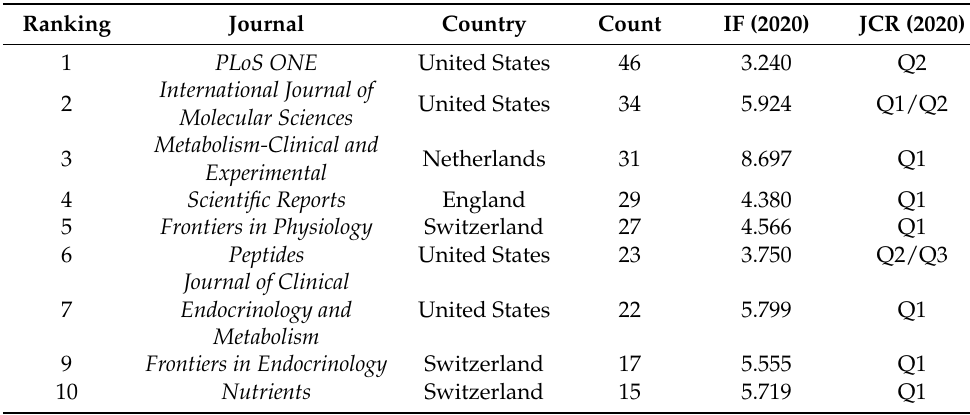
Table 3. Ranking of top 10 active journals that published articles on irisin.